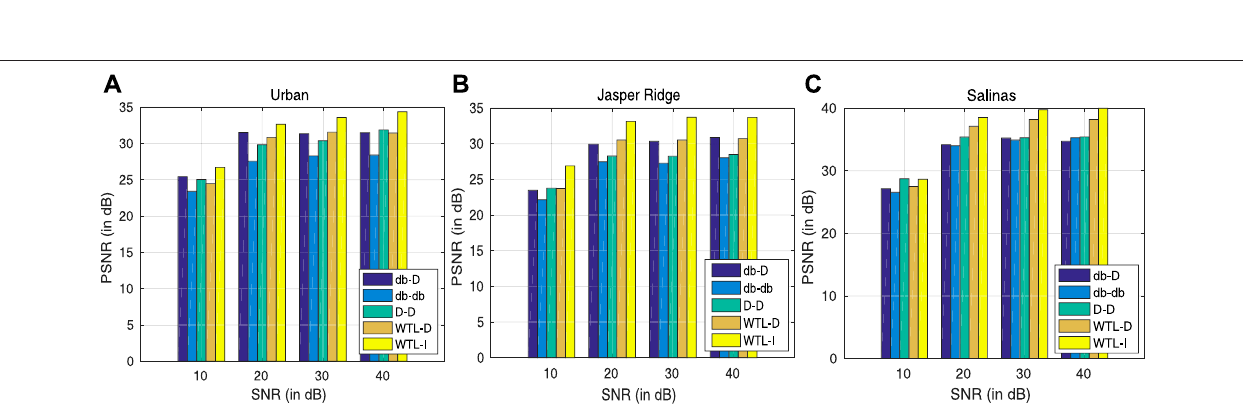
FIGURE 10 | PSNR for reconstruction with different sparsifying basis at different noise levels. (A) Urban, (B) Jasper Ridge, and (C) Salinas. Results are shown at 20 % SR.